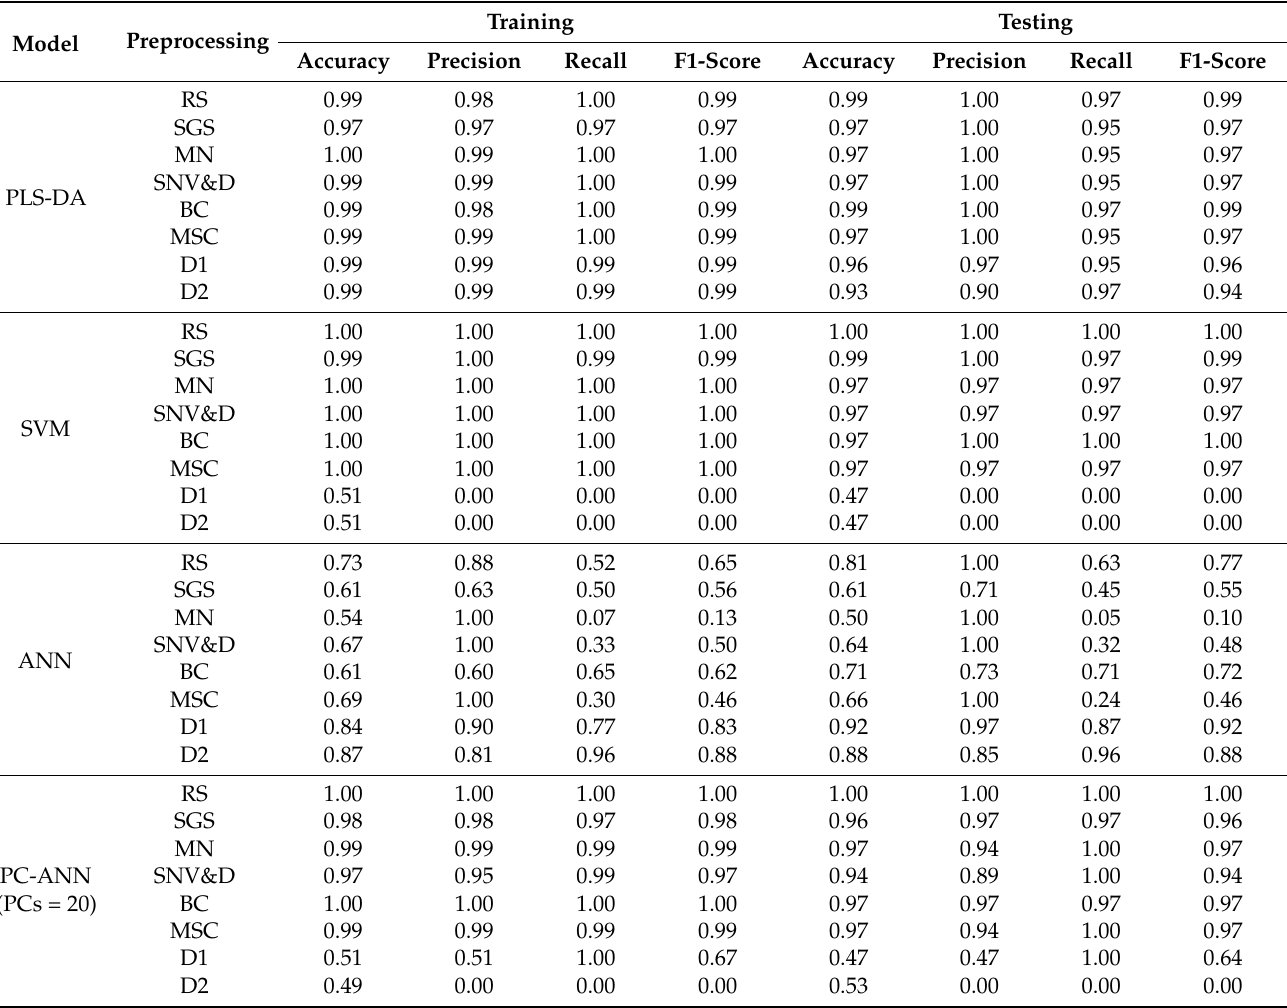
Table 4. Comparison of results among classification models at the calibration